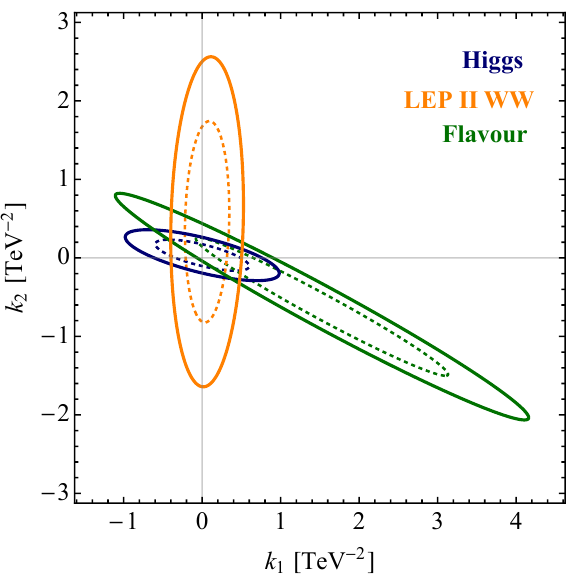
Figure 3. Flavour (green), Higgs (blue) and LEP II WW (orange) constraints on the plane of the Z -pole flat directions, under the assumptions explained in the text. The dotted lines are 1 σ contours, the solid lines are 2 σ contours. The axes correspond to the coefficients of the two independent linear combinations of Wilson coefficients that remain unconstrained by the Z -pole data, as defined in eqs. (4.6) and